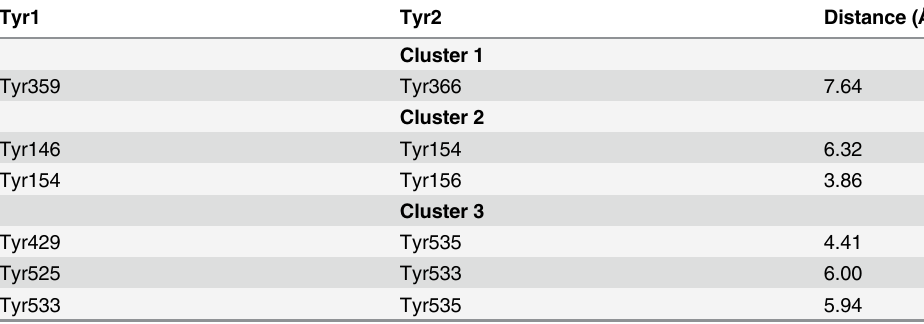
Table 4. Shortest spatial distances between tyrosine residues in full-length native human plasminogen. Tyr1